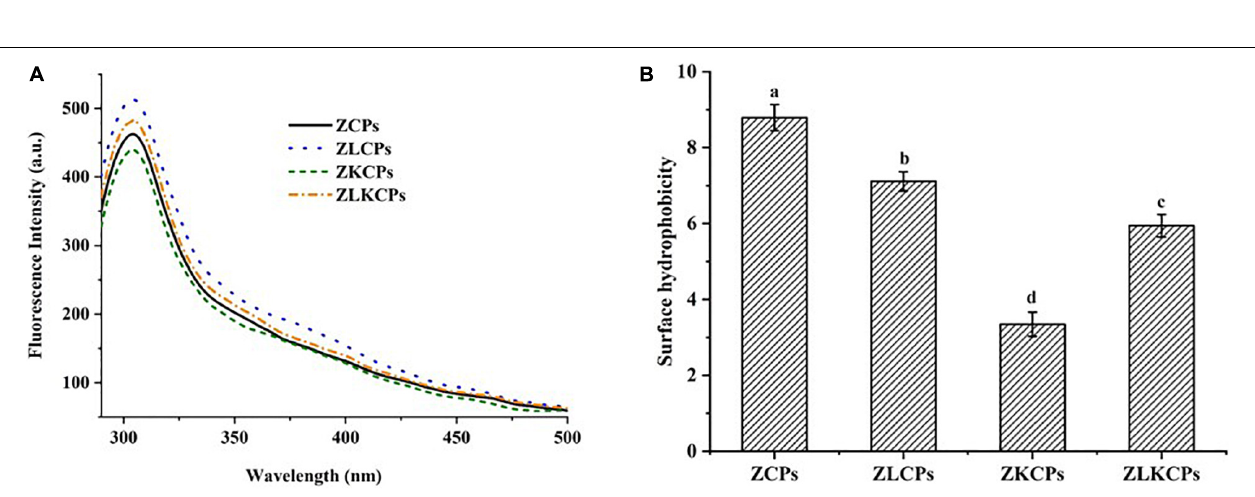
FIGURE 5 | Fluorescence spectroscopy spectra (A) and surface hydrophobicity (B)